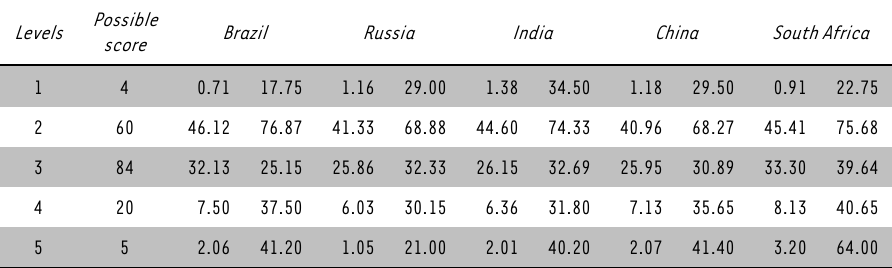
TABLE 4: Element 2 - People management Possible Levels